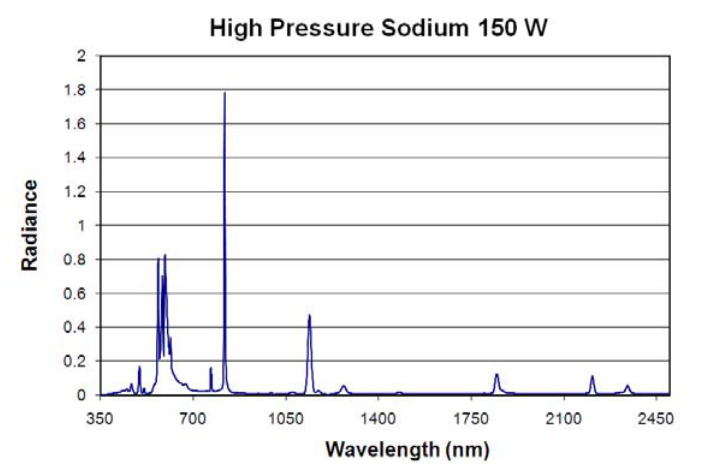
Figure 14. Emission spectrum of a high pressure sodium lamp.